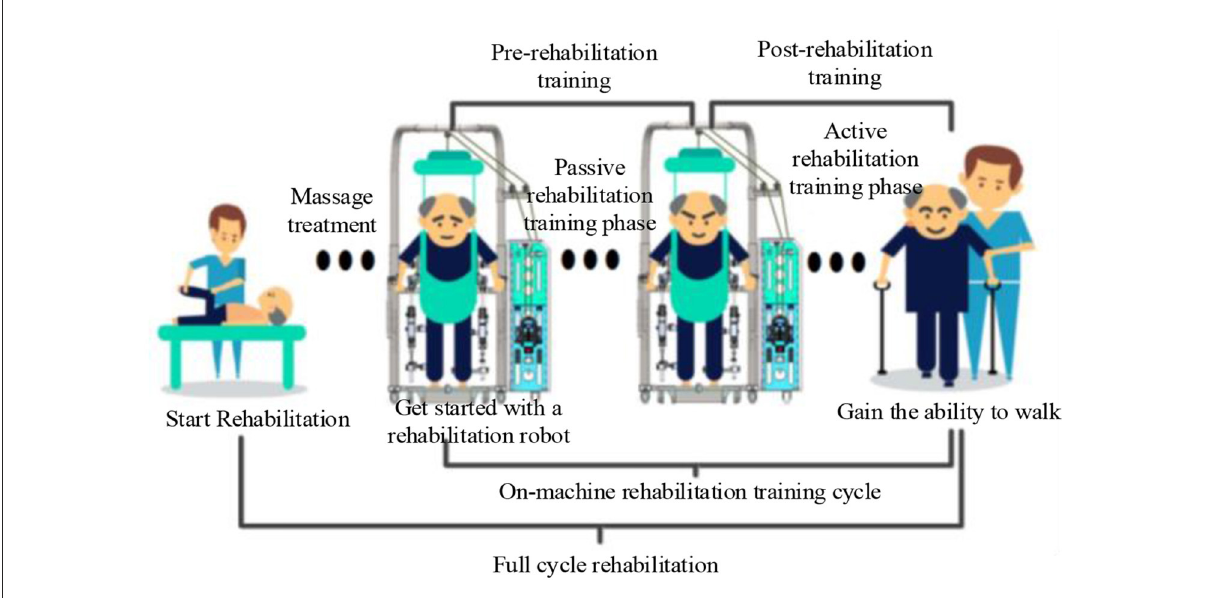
FIGURE12 Schematic diagram of the full cycle of rehabilitation training.